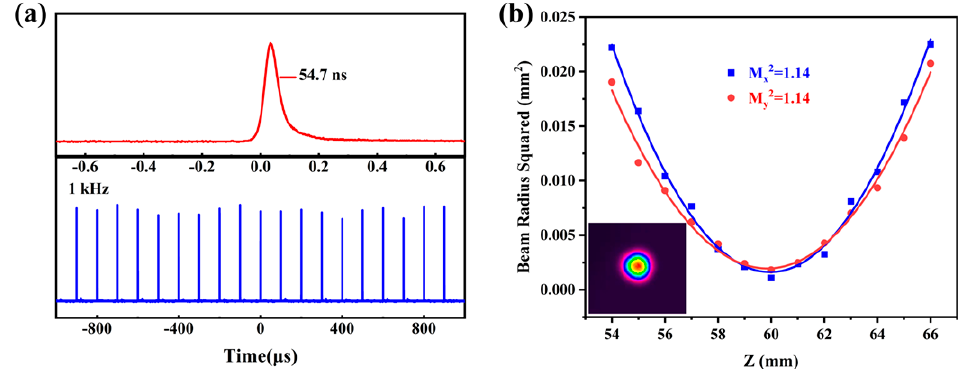
Figure 7. ( a ) The shortest single pulse profile and pulse trains; ( b ) Beam quality of the α -BTM AO Q-switched Pr:YLF laser.